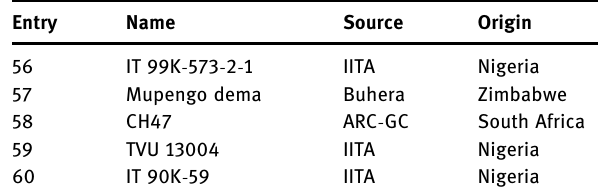
Table 1: List of cowpea accessions used in the study obtained from three geographic